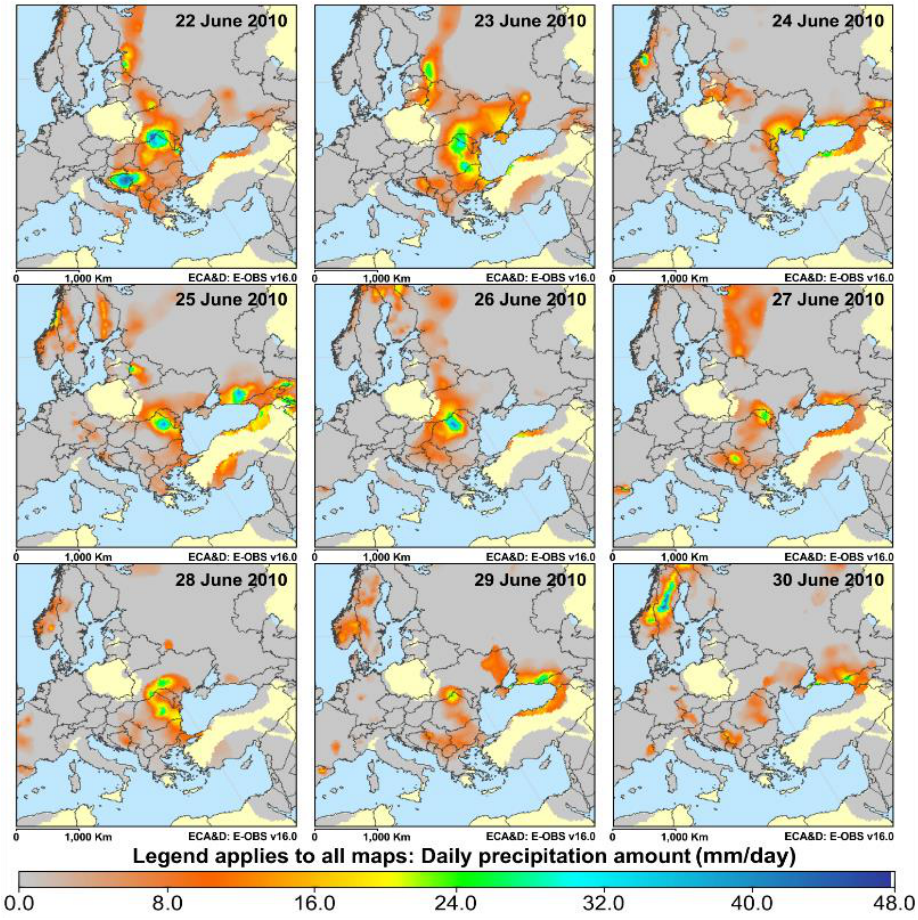
Figure 5. Daily precipitation amounts (mm/day) between 22–30 June 2010 in Central-Eastern Europe, based on daily gridded observational dataset (termed E-OBS v16.0).